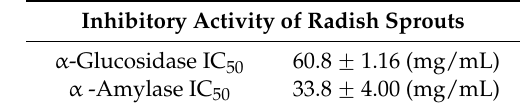
Table 2. In vitro α -glucosidase and α -amylase inhibitory activity of an aqueous extract of radish sprouts. Inhibitory Activity of Radish Sprouts